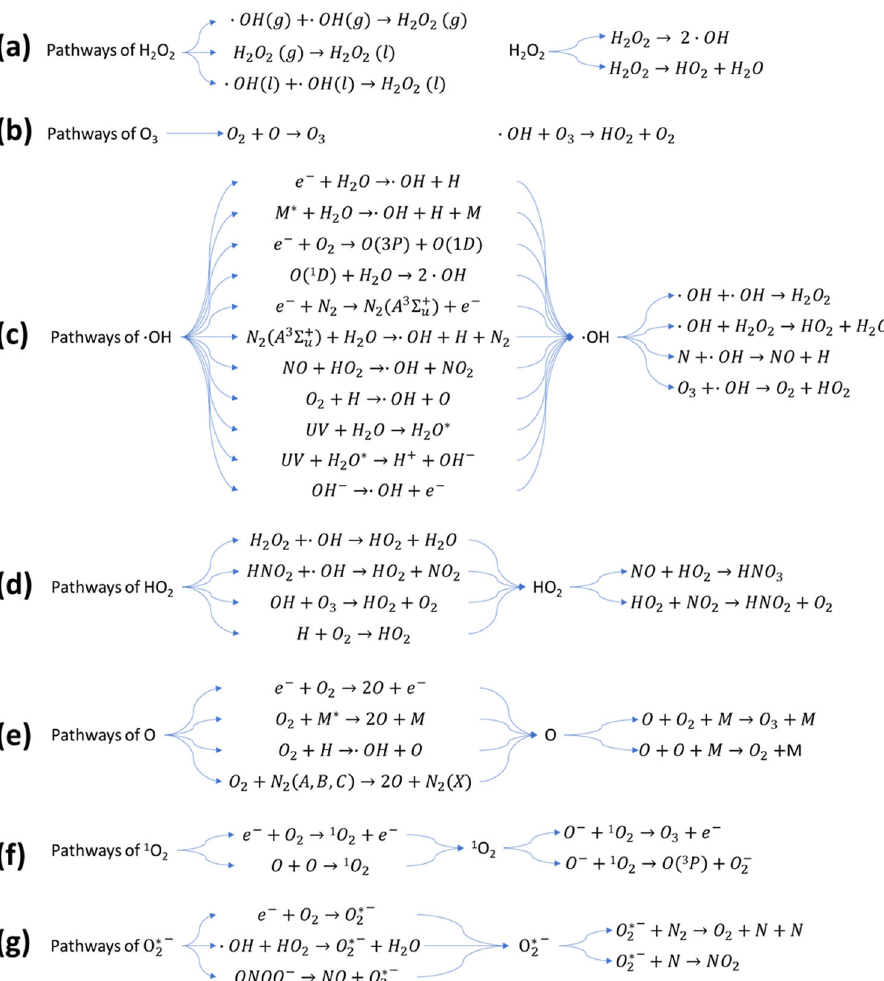
Fig. 4 Reactive oxygen species (ROS) pathways. Pathways of: a H 2 O 2 , b O 3 , c ∙ OH, d HO 2 , e O, f 1 0 2 , g O 2* − . Reactions show the possible formation and destruction of ROS in discharge with